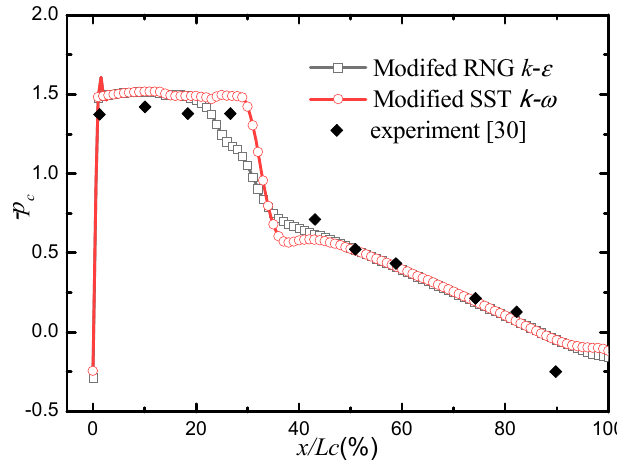
Figure 9. Pressure coefficient distribution of the NACA0015 hydrofoil at 50° С .